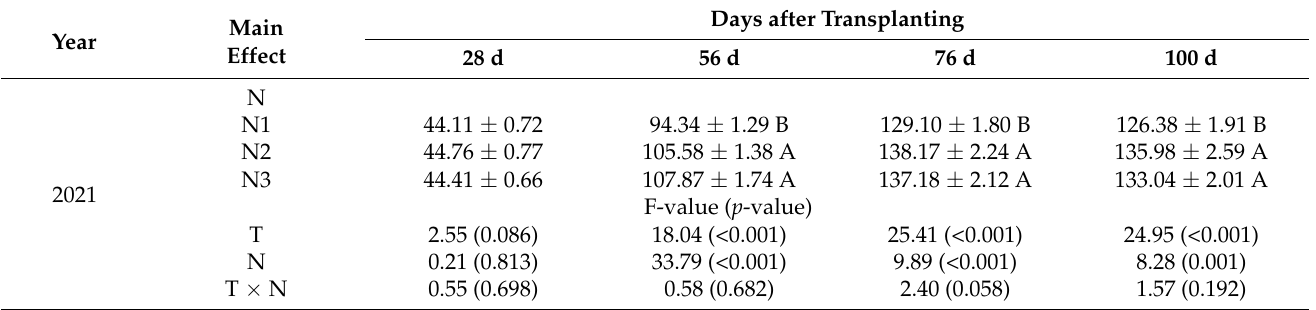
The data are all average ± standard error (the number of samples for each treatment is 9) in the table, different letters within a column indicate significant differences among all treatments, lowercase letters indicate differences between urea types, and capital letters indicate differences between N application rates; * ( p < 0.05) and ** ( p < 0.01) indicate the mean values that significantly differed from the control with Student’s t -test. T: urea type (urea,